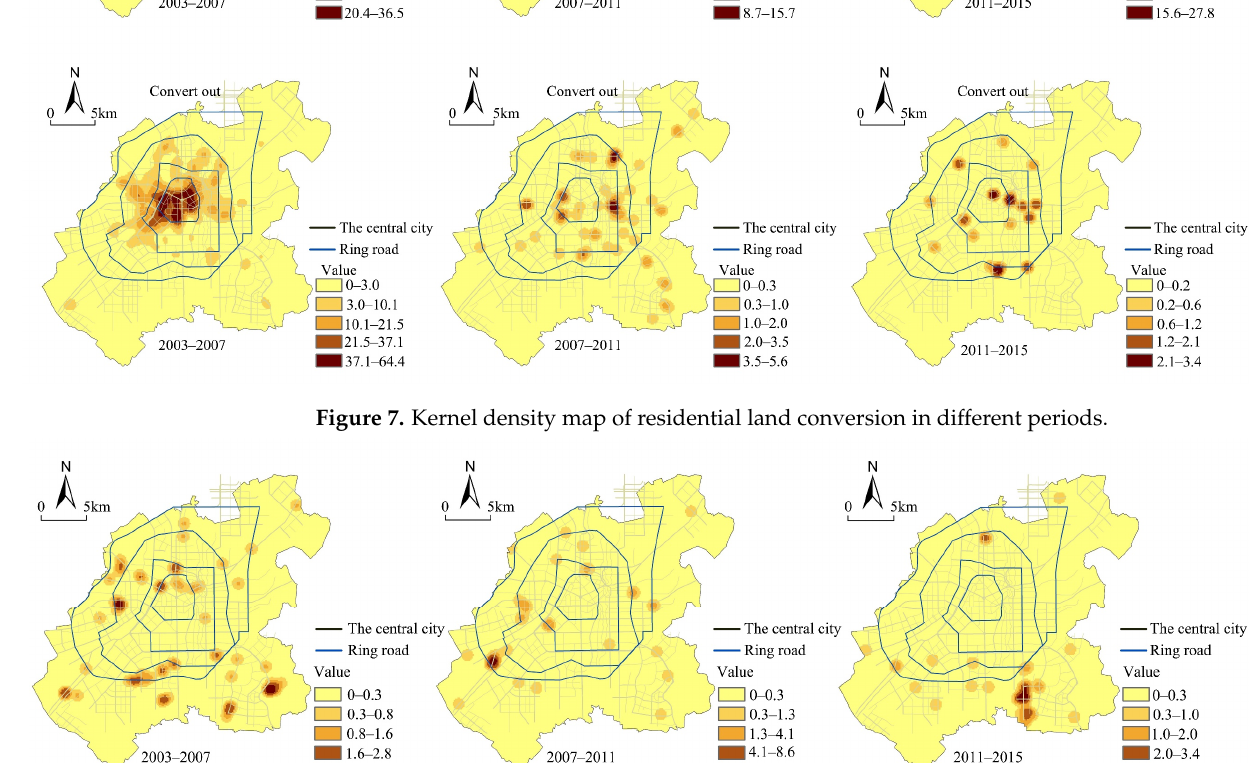
Figure 8. Kernel density map of commercial land expansion in different periods.